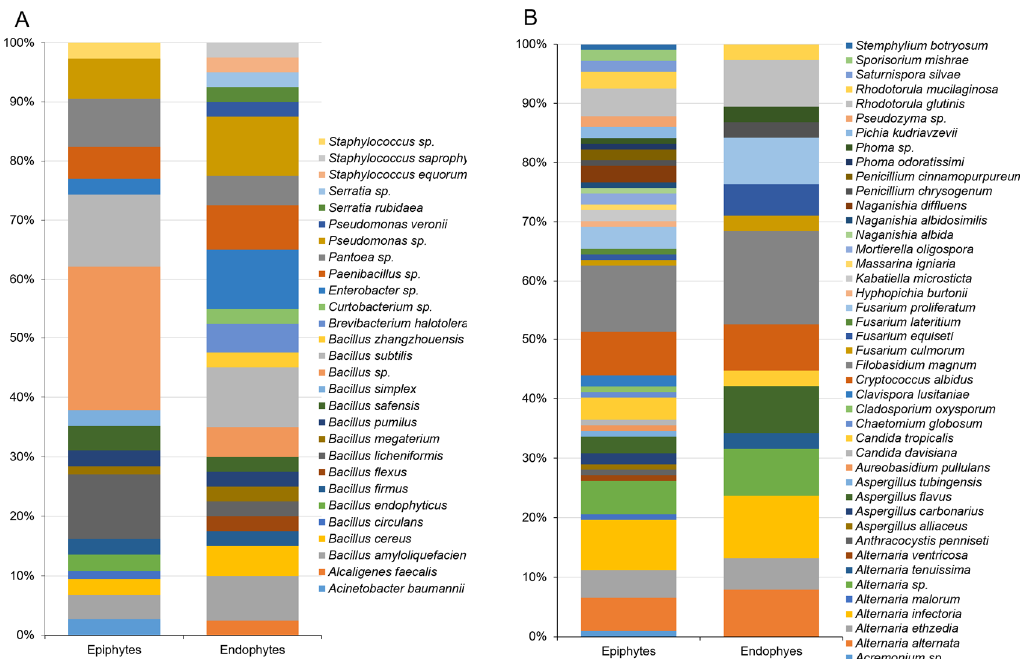
Figure 5. Relative abundance of bacterial ( A ), and fungal ( B ) species isolated by plating from epiphytic and endophytic microflora of stored wheat grains. The isolates were identified by sequencing the 16S rRNA gene in bacteria, ITS region and D1/D2 domain of large-subunit rDNA in filamentous fungi and yeasts, respectively. The sequences were determined via BLAST matches to the NCBI database.